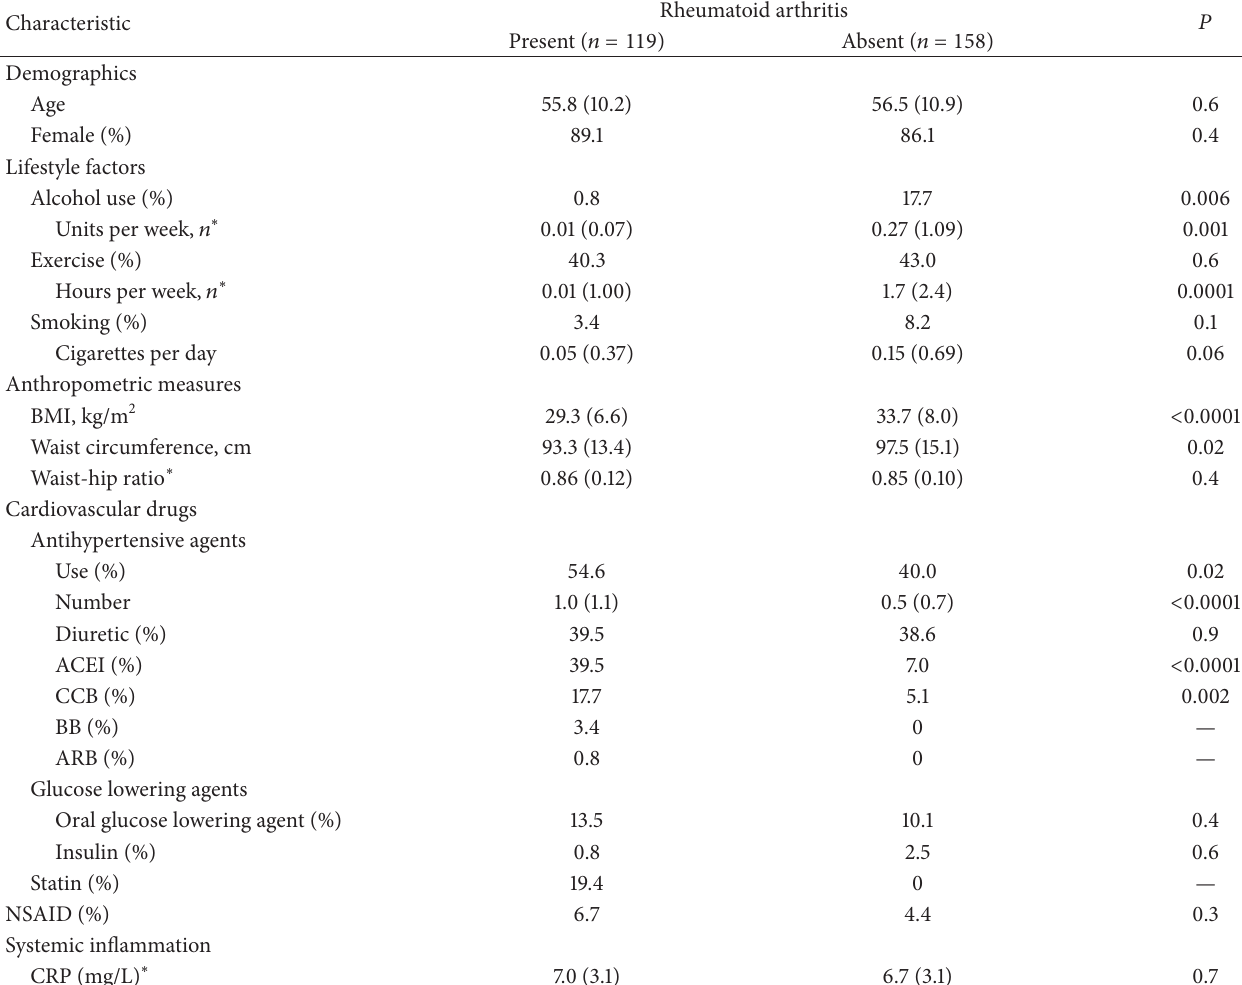
Table 1: Baseline characteristics in subjects with and without rheumatoid arthritis.